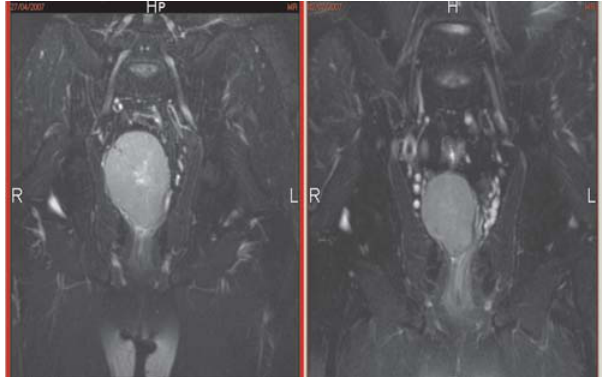
Figure 2 - Pre- and post-treatment MRI illustrating the reduction in tumor